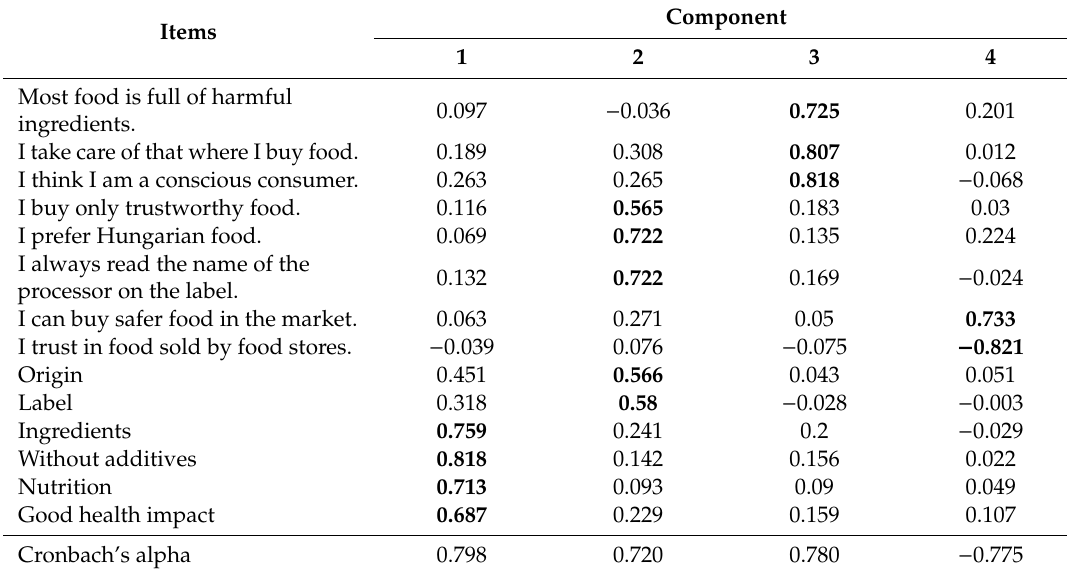
Table 2. Rotated component matrix.